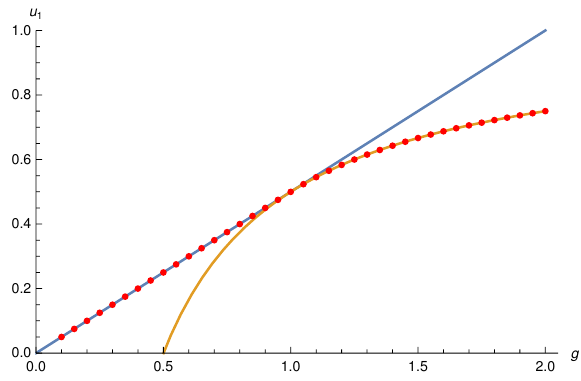
h Tr U i . The red dots are the exact N